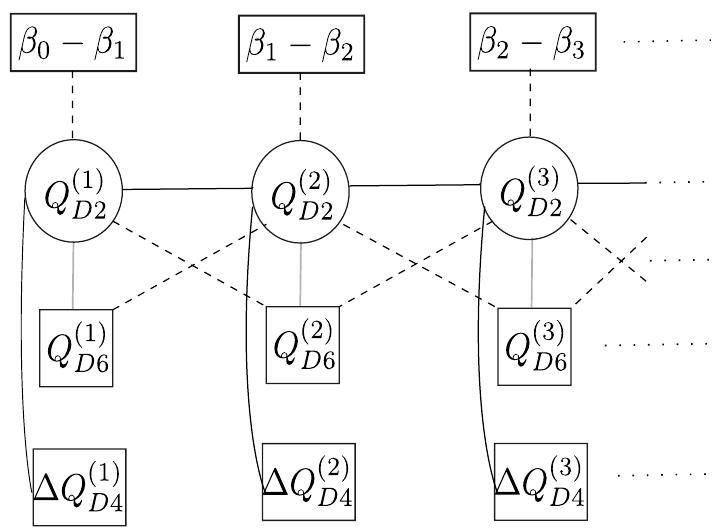
Figure 3 . 2d quivers associated to the AdS 3 solutions (3.19)–(3.21). Circles denote (4 , 4) vector multiplets, black lines (4 , 4) bifundamental hypermultiplets, grey lines (0 , 4) bifundamental twisted hypermultiplets and dashed lines (0 , 2) bifundamental Fermi